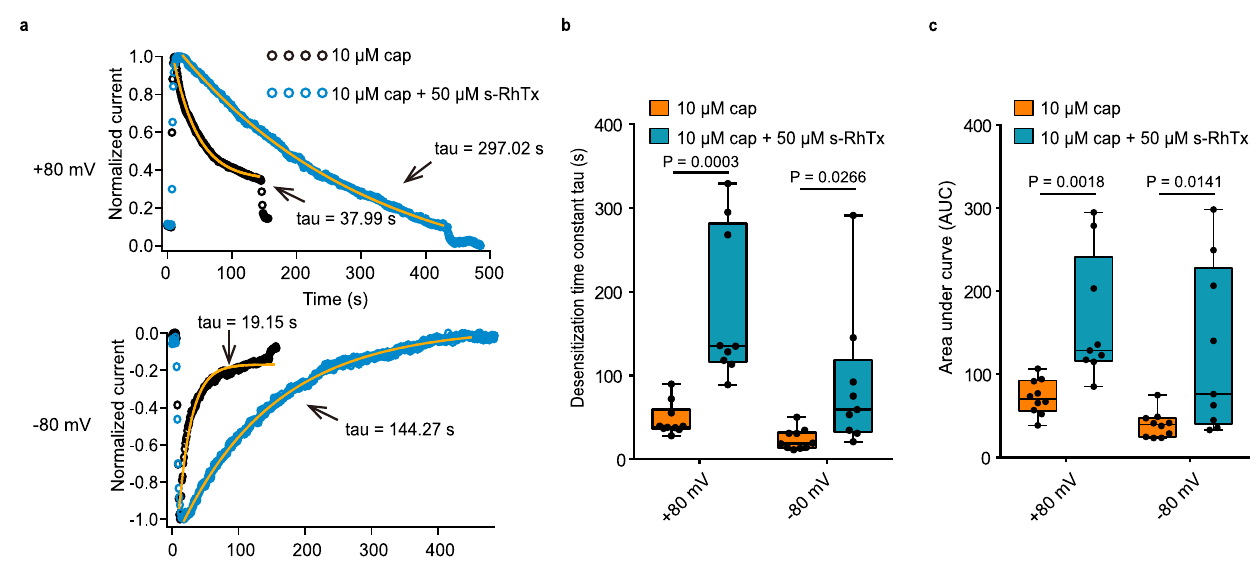
Fig. 3 | s-RhTx slowed down the desensitization process of TRPV1 in the pre- senceofcalciumand10 μ Mcapsaicin.a Comparisonofthetimeconstantstauof acute desensitization of TRPV1 in response to 10 μ M capsaicin (in black) or the mixture of 10 μ M capsaicin and 50 μ M s-RhTx (in blue) at +80mV (top panel) and − 80mV (bottom panel). b Summary of desensitization time constant of a (Data in box and whisker plot were given from the minima to maxima, the bounds of box represent the 25th percentile and 75th percentile and the middle line of box is the median. Data were represented as mean±S.E.M. from biologically independent